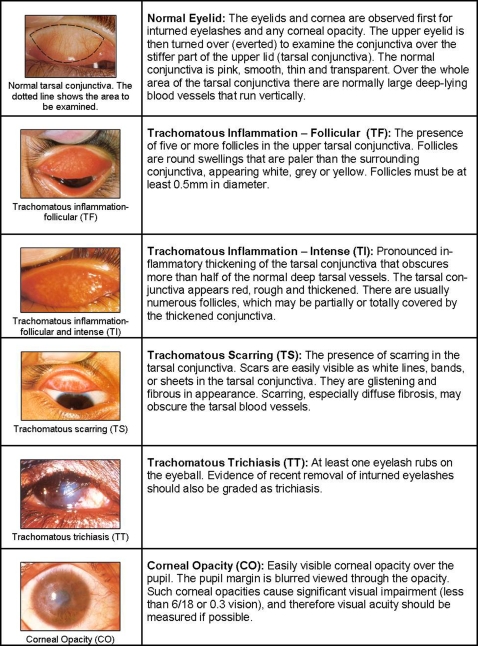
The WHO simplified grading scheme for assessment of trachoma.Reproduced from Thylefors, 1987 [18].